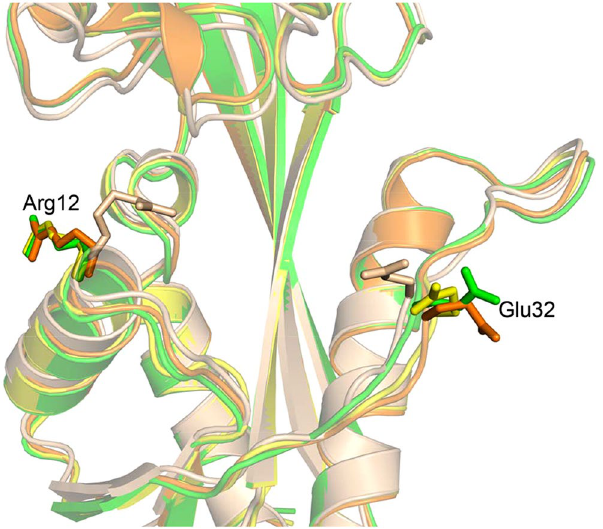
Figure 2. Structure superposition of four structure of YhdE_E33A. YhdE_E33A structure crystallized without dTTP, (4P0U, orange), YhdE_E33A structure co-crystallized with dTTP (4P0E, wheat), YhdE_E33A structure A soaked with dTTP (chain A, green) and YhdE_E33A structure B soaked with dTTP (chain B, yellow) are aligned together. The protein side chains are shown as sticks along with protein backbone as